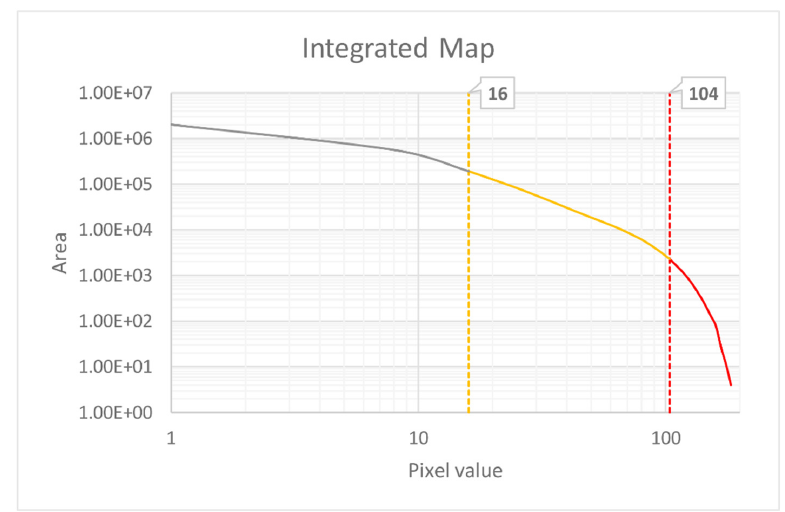
Figure 17. C-A plot of the integrated map used for classifying and separating the anomaly population.